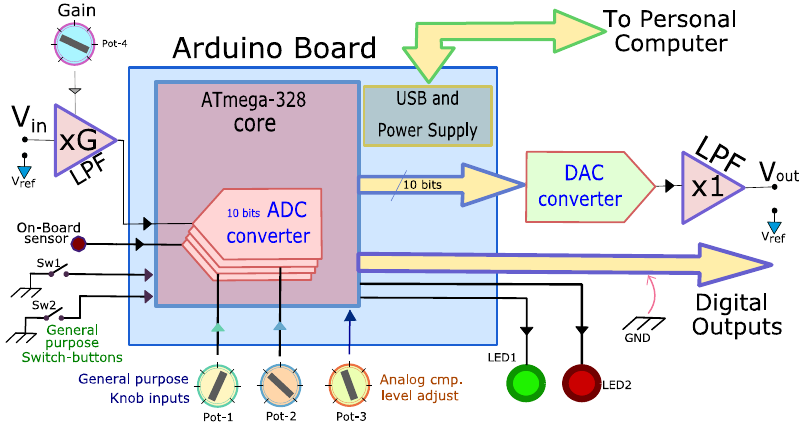
Figure 2. Block diagram of the training platform